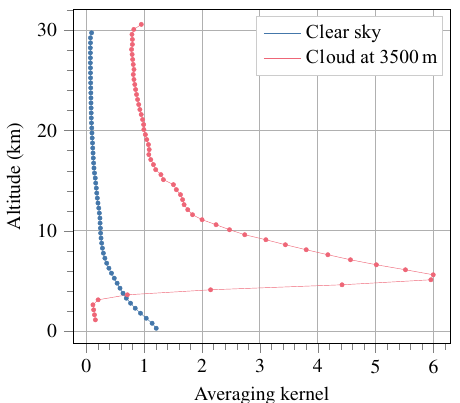
Figure 9. Example of averaging kernels for H 2 O for a clear-sky measurement (blue) and a scene with optically thick clouds (red).